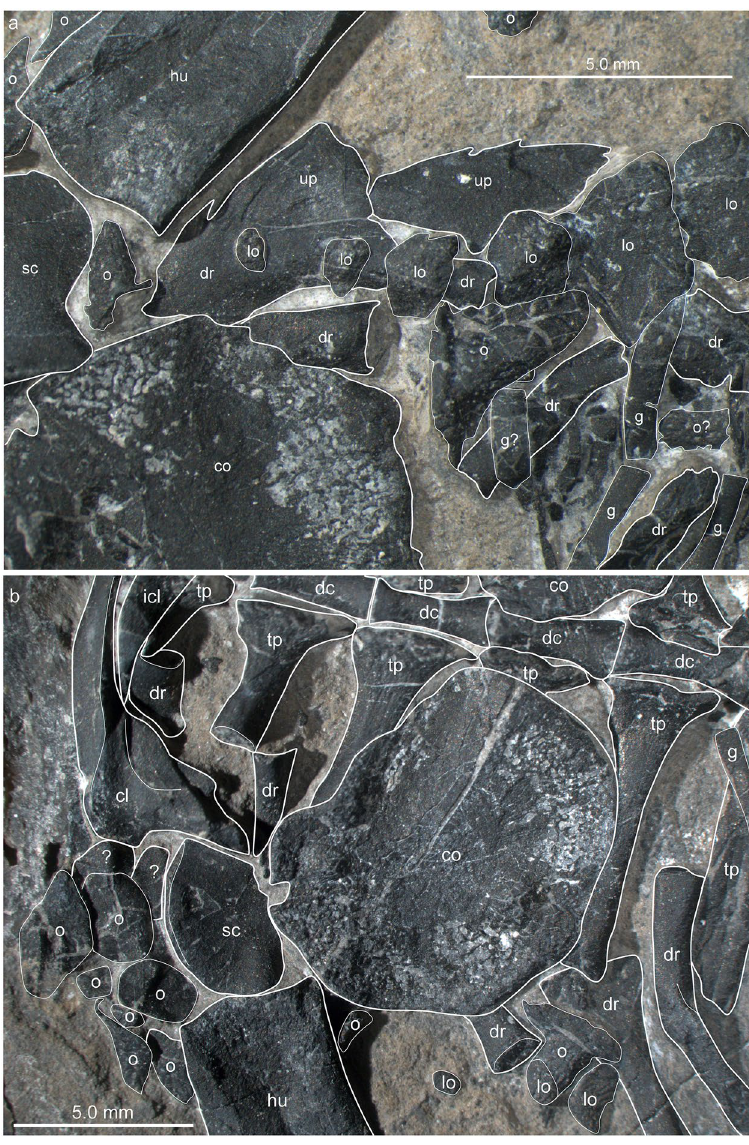
Figure 10. Details of the left and right lateral osteoderm series in the anterior thoracic region of Eusaurosphargis dalsassoi (PIMUZ A/III 4380). ( a , b ) Photographs overlain by interpretative drawings. Abbreviations used in the figure are clavicle (cl), coracoid (co), thoracic/dorsal vertebral centrum (dc), thoracic/ dorsal rib (dr), gastralia (g), humerus (hu), interclavicle (icl), lateral osteoderm (lo), osteoderm (o), uncinate process (up), scapula (sc), and transverse process of thoracic/dorsal vertebra